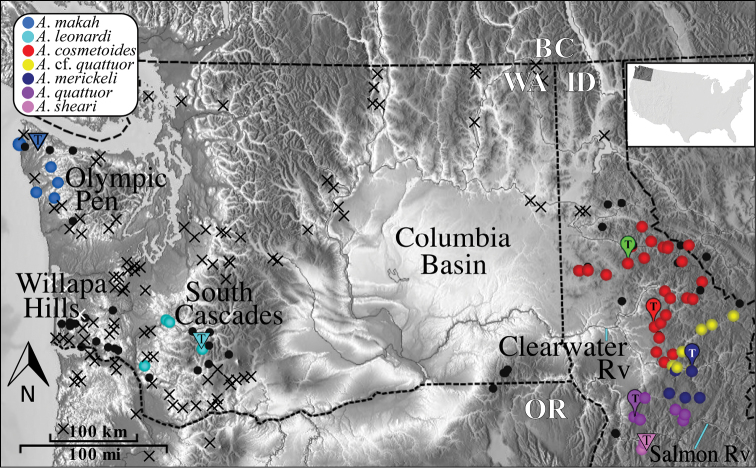
Distribution of Acuclavella. Black circles are localities where Acuclavella were specifically targeted, but not encountered. Black crosses indicate localities where general surveys of litter invertebrates (e.g., Opiliones, Diplopoda, terrestrial Gastropoda) were conducted and Acuclavella were not encountered. Blue lines point to labeled rivers. Type localities (T) from Shear (1986) are indicated with paddle icons; green paddle = Acuclavella shoshone. Type localities of species described in this work are indicated with inverted triangles. Image saved from Google Earth.